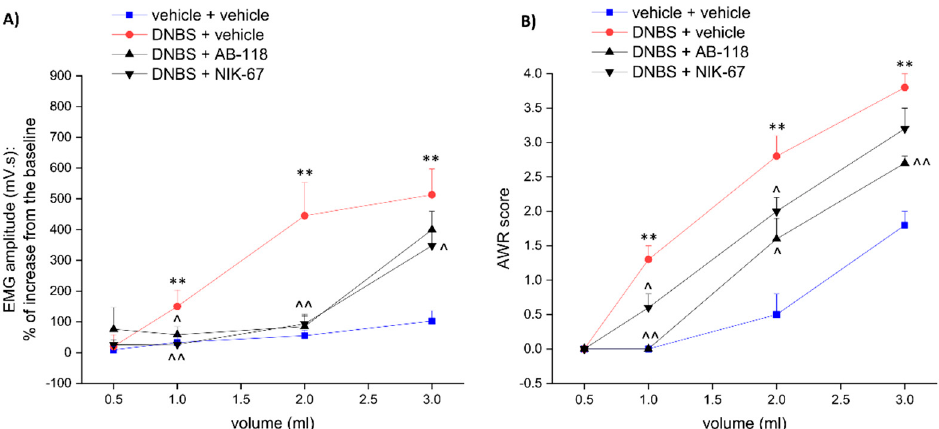
Figure 3. Effect of AB-118 and NIK-67 on the persistence of visceral pain in the post-inflammatory phase of colitis induced by DNBS in rats. Tests were performed 15 days after DNBS injection (30 mg in 0.25 mL EtOH 50%), 24 h after the last administration of the CAIV inhibitor, AB-118 or NIK-67 (75 mg kg − 1 p.o.). Visceral sensitivity was assessed by measuring ( A ) the animals visceral motor response (VMR) and ( B ) the abdominal withdrawal response (AWR) to colon rectal distension (0.5, 1, 2, 3 mL balloon inflation). Each value is the mean ± S.E.M. and represents the mean of 5 rats per group. ** p < 0.01 vs. vehicle + vehicle treated animals. ˆ p < 0.05 and ˆˆ p < 0.01 vs. DNBS + vehicle-treated animals.